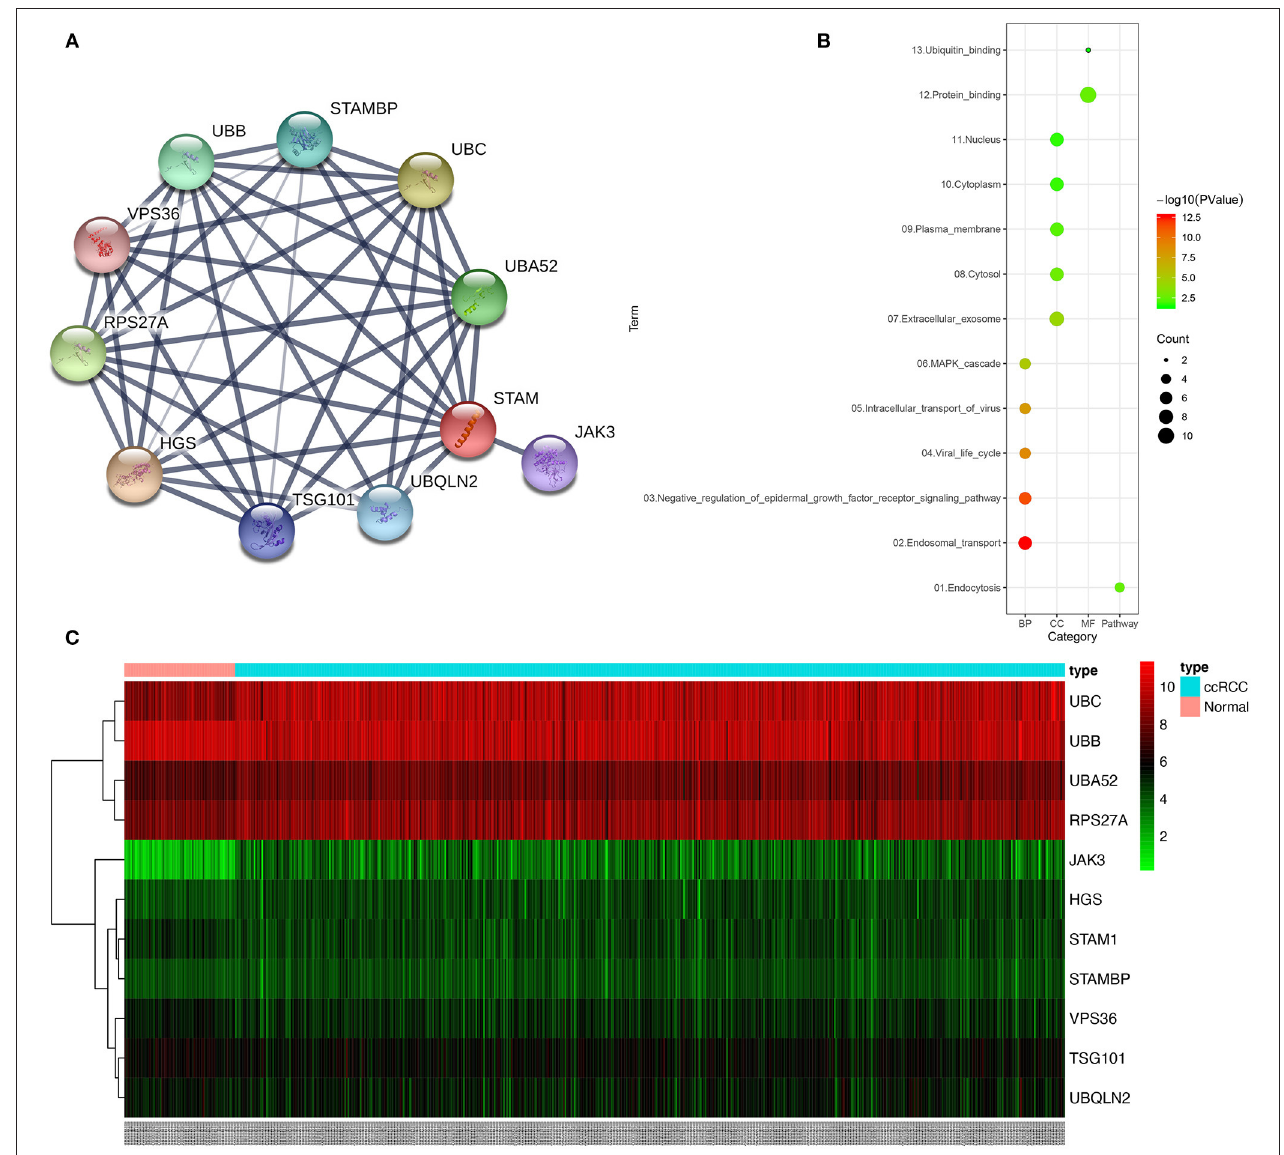
FIGURE 8 | Protein–protein interaction (PPI) network, gene ontology (GO) functional annotation, and Kyoto Encyclopedia of Genes and Genomes (KEGG) pathway enrichment analyses of genes correlated with STAM1. The PPI network identified the top 10 genes correlated with STAM1 (A) . GO functional annotation and KEGG pathway enrichment analysis of genes included in the PPI network (B) . Heatmap of the top 10 genes correlated with STAM1 in TCGA (C)